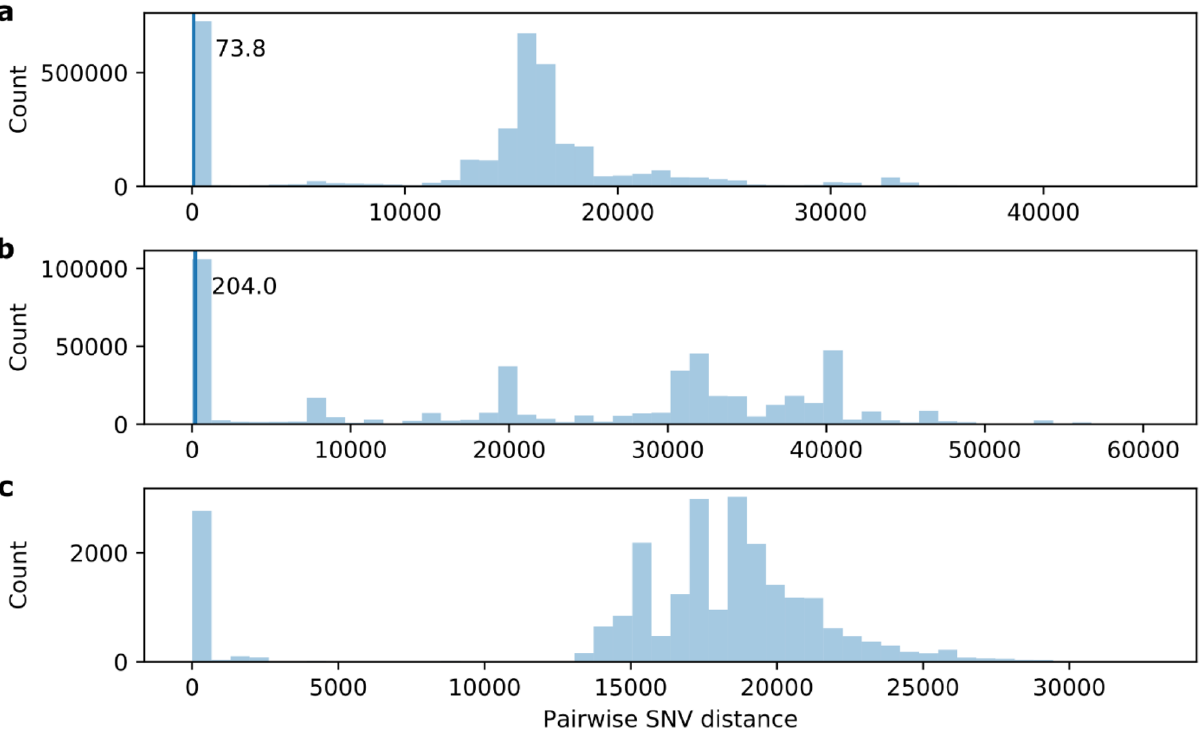
Figure 4. Distribution of unadjusted pairwise SNV distances of global M. abscessus isolates. The 95th percentile of pairwise within-patient SNVs of the Ontario isolates is indicated by vertical lines, but could not be calculated for M. bolletii. ( a ) M. abscessus ( b ) M. massiliense ( c ) M.